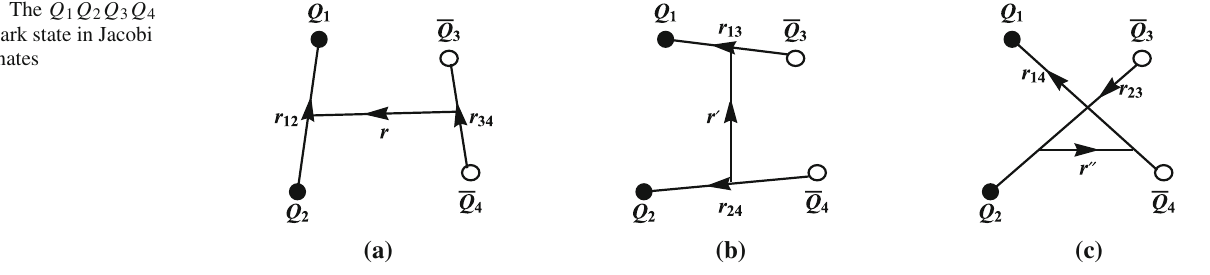
Table 1 Possible configurations for the cc ¯ c ¯ c and bb ¯ b ¯ b systems. The subscripts and superscripts denote the spin and color quantum numbers, respectively System J PC